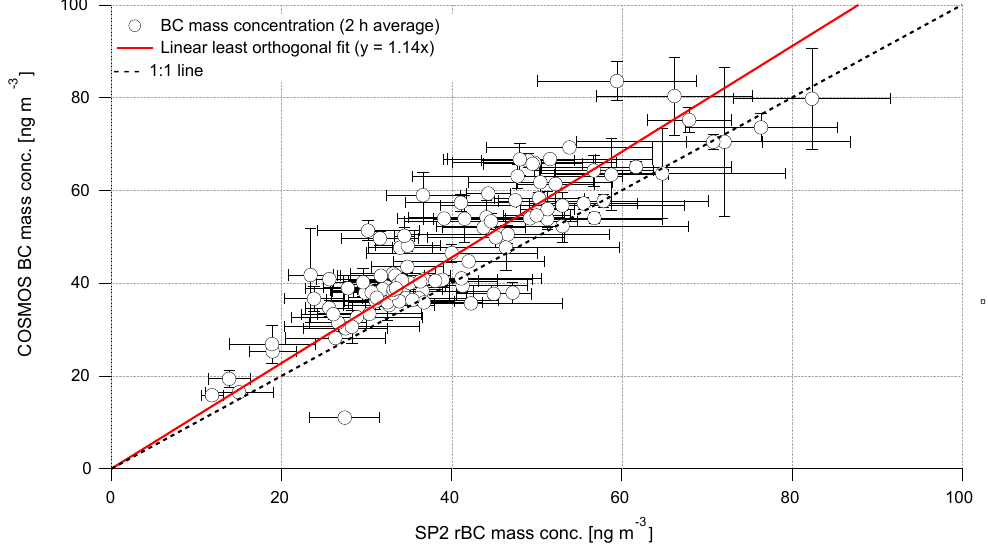
Figure 5. Comparison of black carbon mass concentrations measured by COSMOS and SP2. Each individual data point represents the 2h mean while error bars indicate the standard